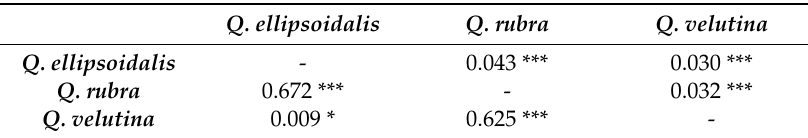
Table 1. Pairwise F ST values by species across 11 non-outlier microsatellite markers (upper triangle) and at FIR013 (lower triangle) using GeneAlEx [34].